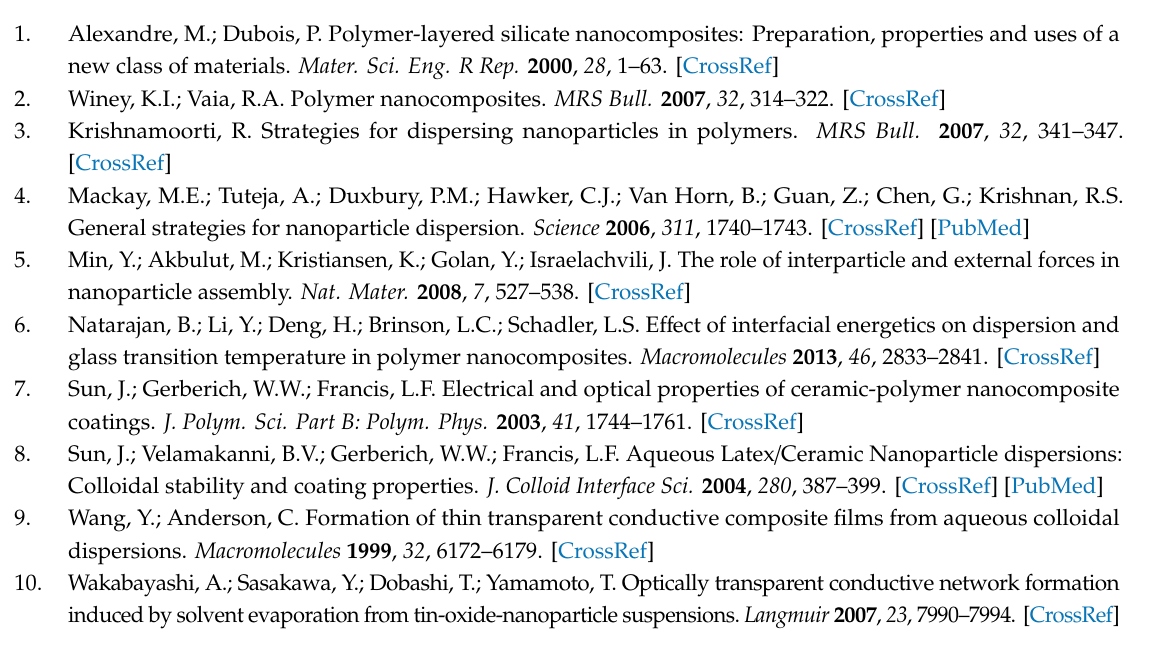
Figure S1: Specific heat capacity of nanocomposites in respect to sample mass. Specific heat capacities of ATOu and ATOc are also